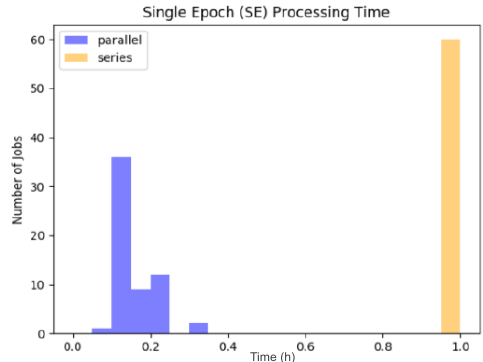
Figure 3. Purple: Wall time for the SE stage of the updated parallel workflow for a single exposure. There are 59 parallel jobs, one for each CCD used in the analysis. Yellow: wall time for SE processing of the same exposure using the O1 / O2 pipeline. In the O1 / O2 pipeline there was one SE job per exposure, normalized to 59 here for illustrative purposes. Since all 59 jobs are independent in the O3 pipeline, the e ff ective time for SE processing to complete is simply that of the longest single job, providing an improvement factor of three to five depending on the individual exposure. The O3 pipeline jobs also immediately move to the next stage of processing in each CCD, whereas in the O1 / O2 pipeline no di ffi mg jobs for a given exposure would start until all SE processing was